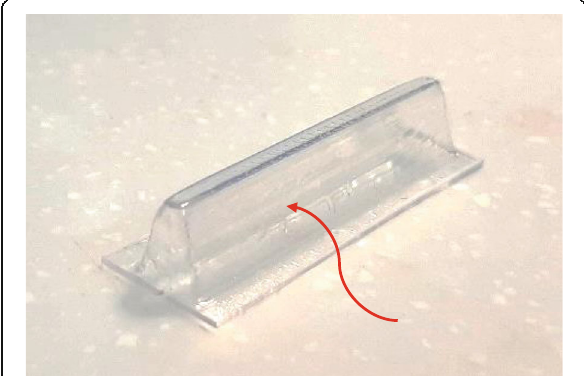
Fig. 2 Thermoformed sheet after removing of mold from inside. The mentioned surfaces were used for